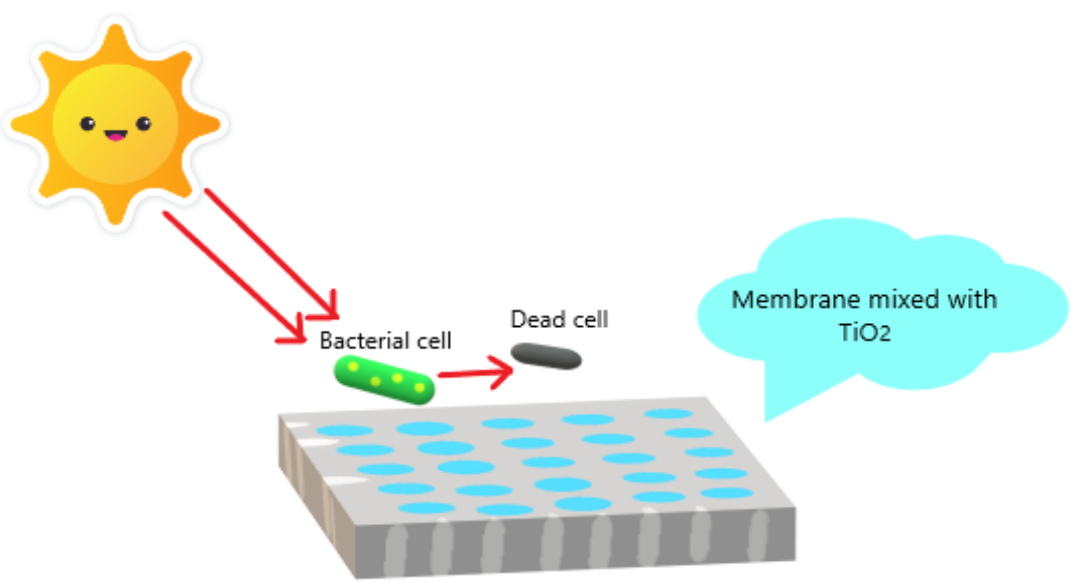
Figure 11. Photocatalytic membrane (polymeric membrane with TiO 2 ).